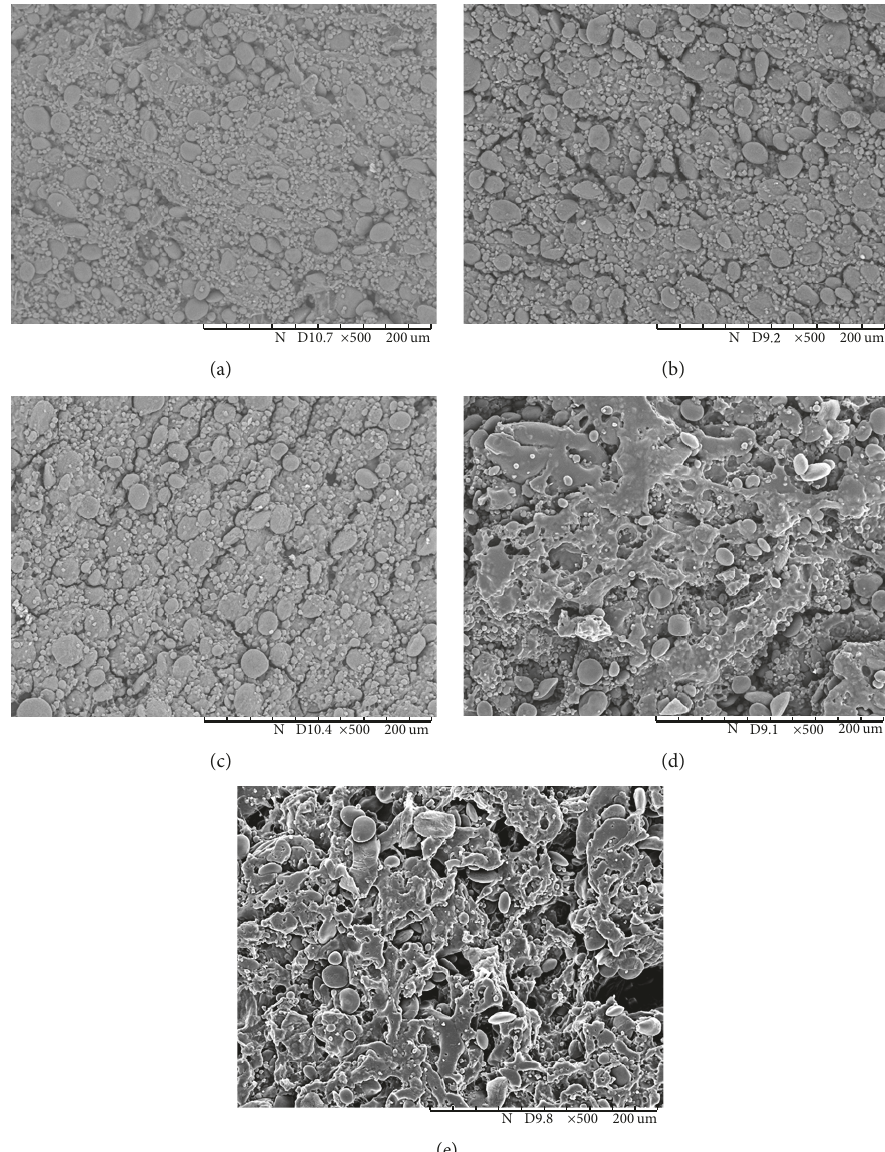
Figure 3: Scanning electron micrographs of dough with different percentage substitution of WP and SP: (a) Control; (b) Control + 10% WP; (c) Control + 30% WP; (d) Control + 10% SP; (e) Control + 30%